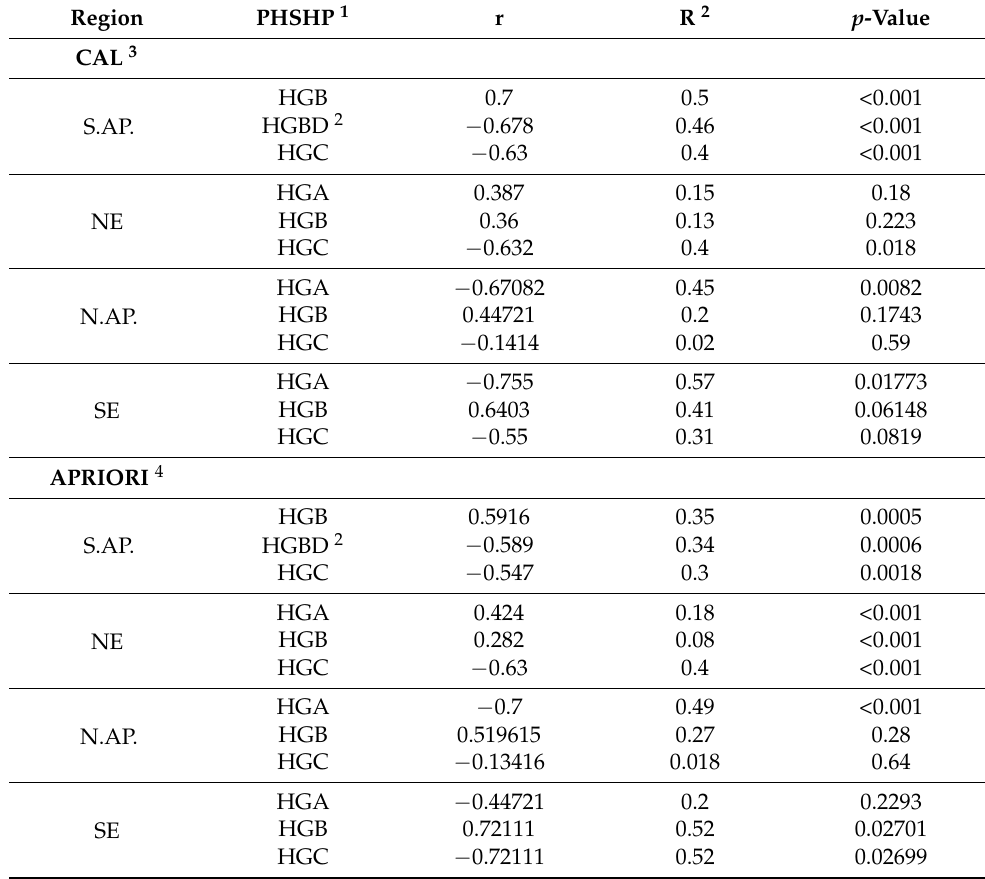
Table 3. The correlation between NS and predominant soil hydrologic groups (PHSHP) in the study regions.